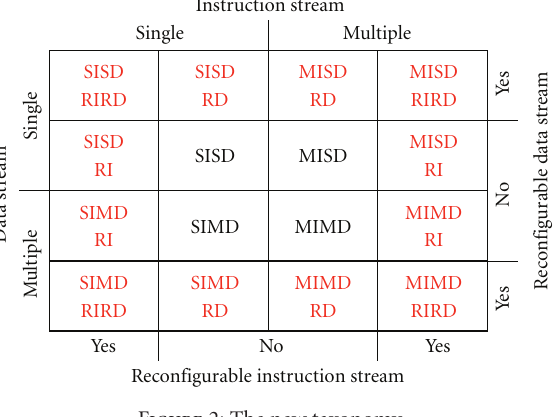
Figure 2: The new